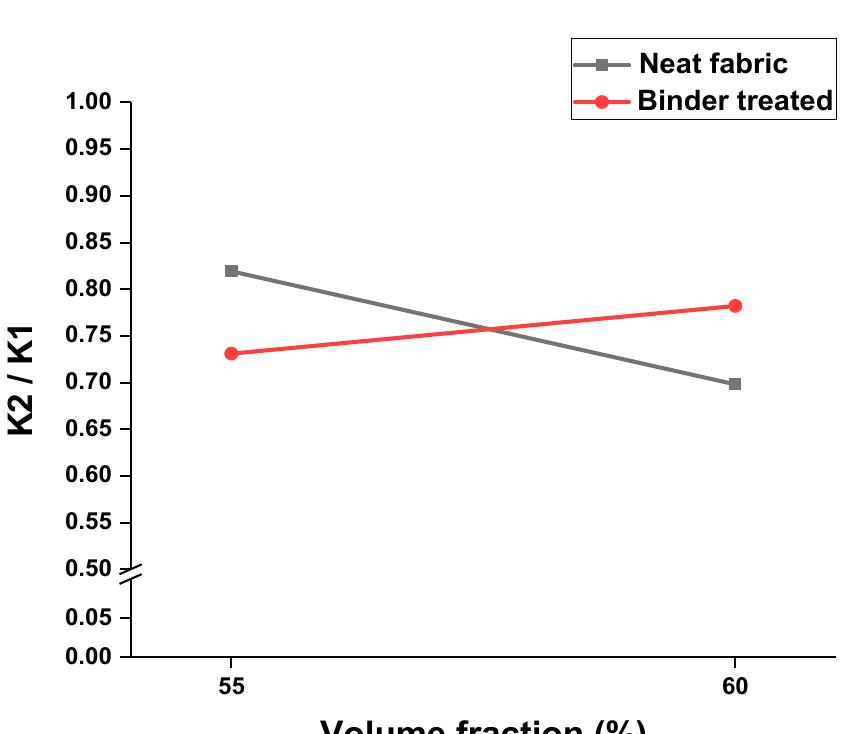
Figure 7. The value of K2/K1 according to the binder treatment.